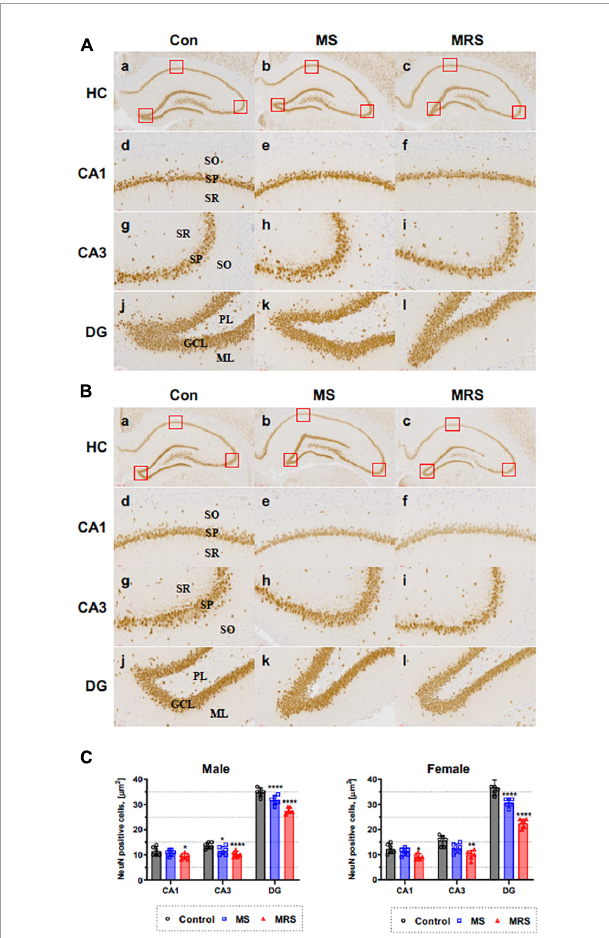
FIGURE7 Immunohistochemical staining of NeuN in the brain of male (A) and female (B) rats in the control, MS, and MRS groups. The NeuN immunoreactive (brown color) revealed on all hippocampus region (GCL, granule cell layer; ML, molecular layer; PL, polymorphic layer; SO, stratum oriens; SP, stratum pyramidale; and SR, stratum radiatum) [a–c: hippocampus (HC), d–f: CA1, g–i: CA3, j–l: dentate gyrus (DG) (count area: 100 × 100 µ m, a,b: × 100, c–h: × 400)]; (C) Comparison of % relative number of NeuN staining cells in the CA1, CA3, and DG region; data are presented as means ± SD ( n = 6). Statistical significance was defined as a p -value less than 0.05 (* p < 0.05, ** p < 0.01, **** p <